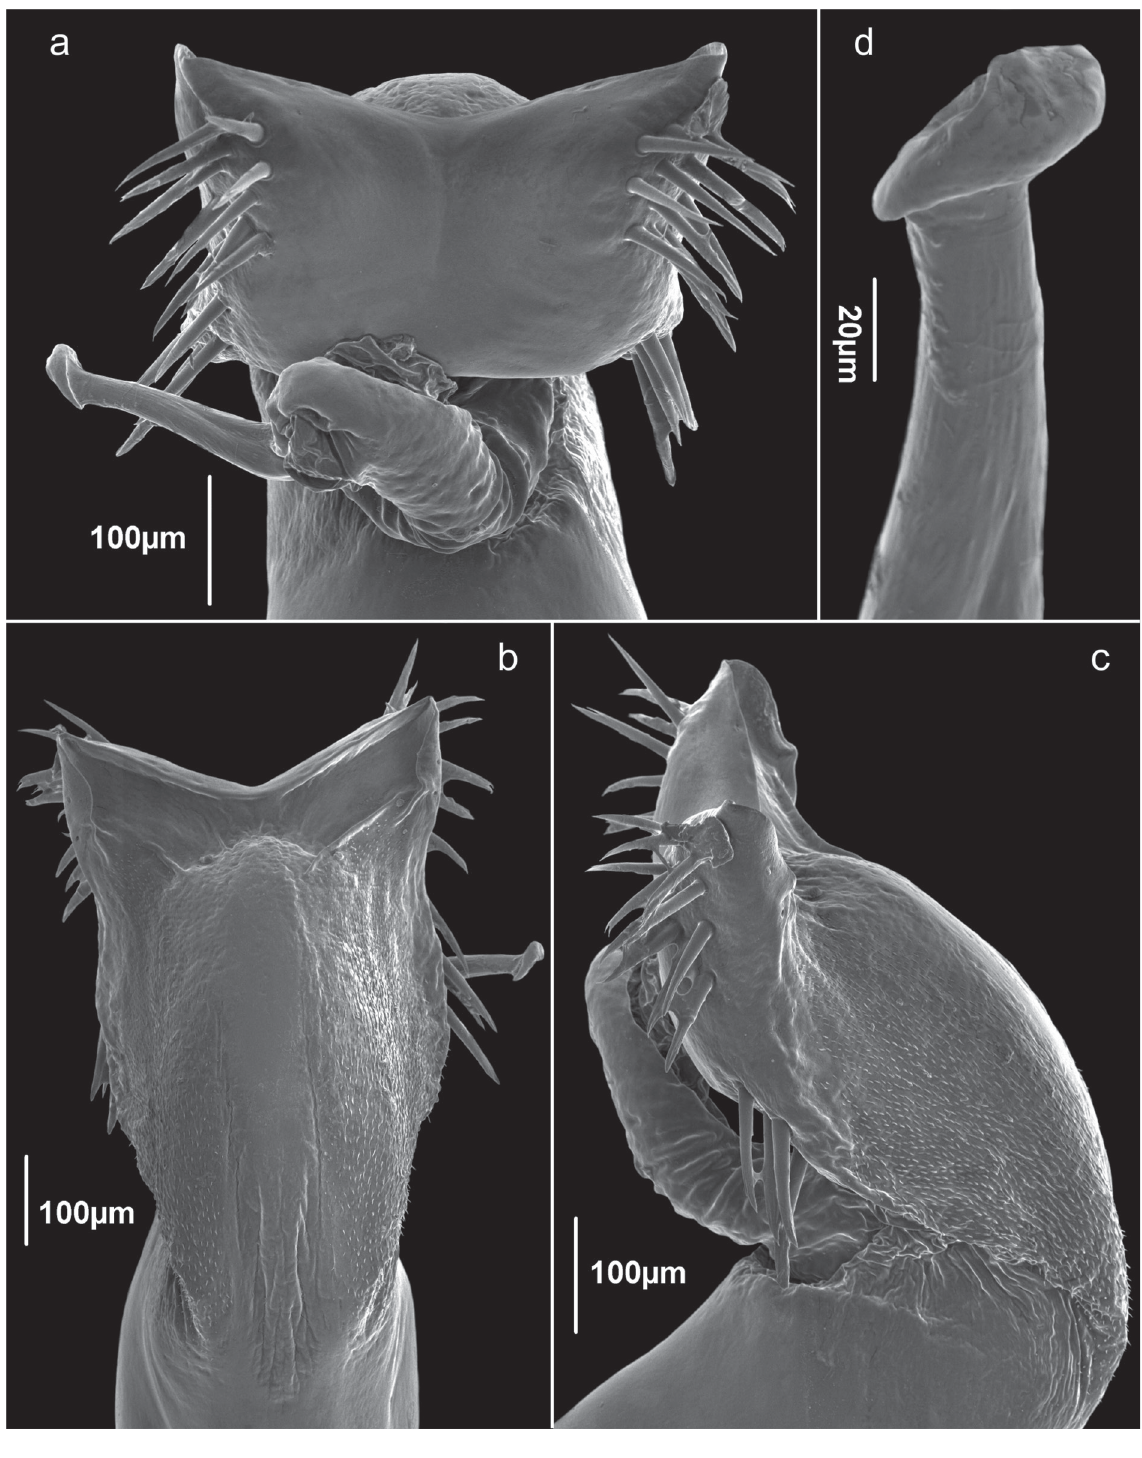
Fig. 12. Phalangodus gyes sp. nov., paratype, ♂ (MNRJ 17907). Distal portion of the penis. a . Dorsal view. b . Ventral view. c . Lateral view. d . Stylar caps, lateral